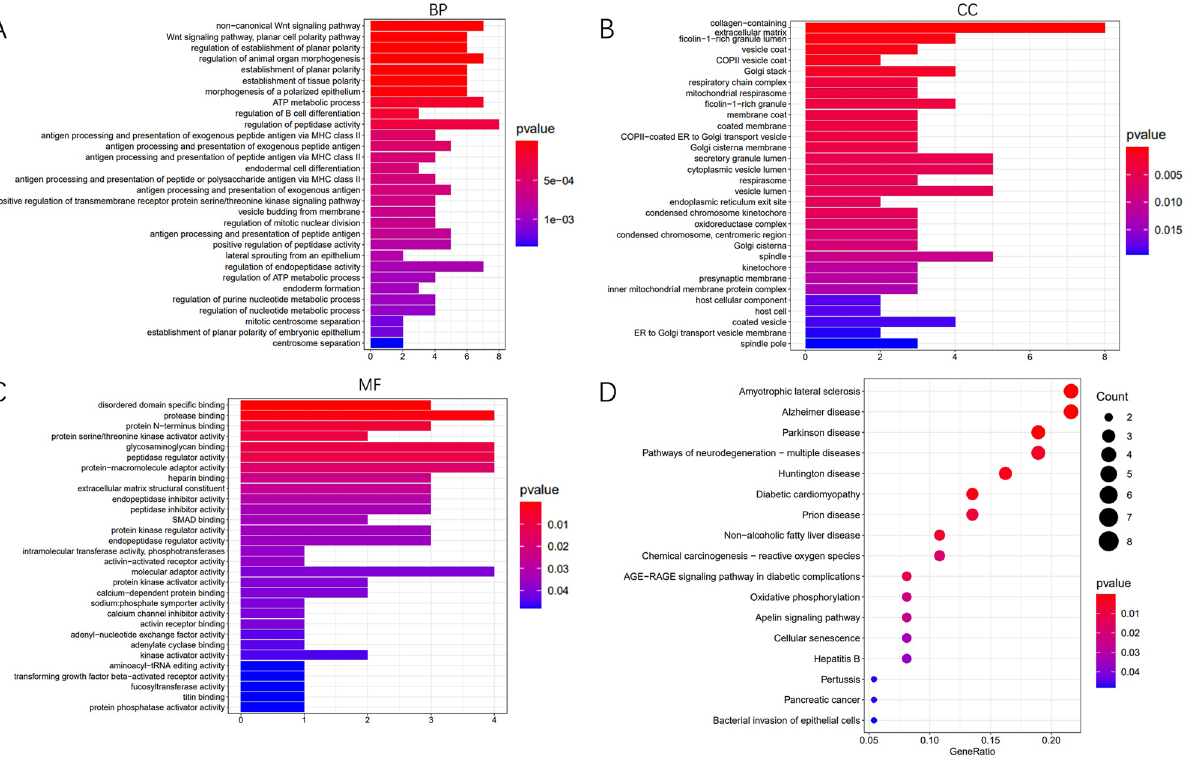
Figure 6. GO and KEGG enrichment analyses of the 72 mRNAs in the ceRNA network: ( A ) biological process, ( B ) cellular component and ( C ) molecular function. ( D ) Enrichment analysis of KEGG pathways 20–22 .